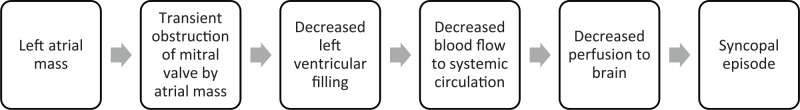
Syncopal episode physiology.